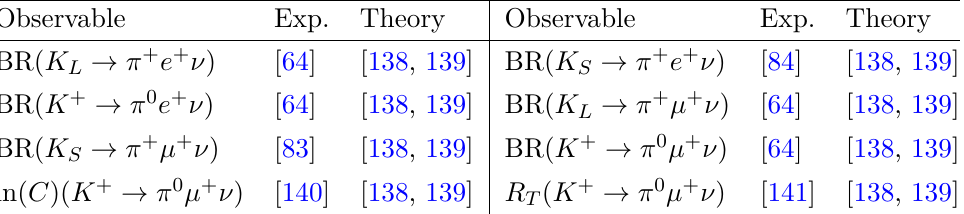
Table 5 . The “ K ‘ 3 ” observables used in smelli , along with the relevant experimental measurements and theory papers used in the computation.